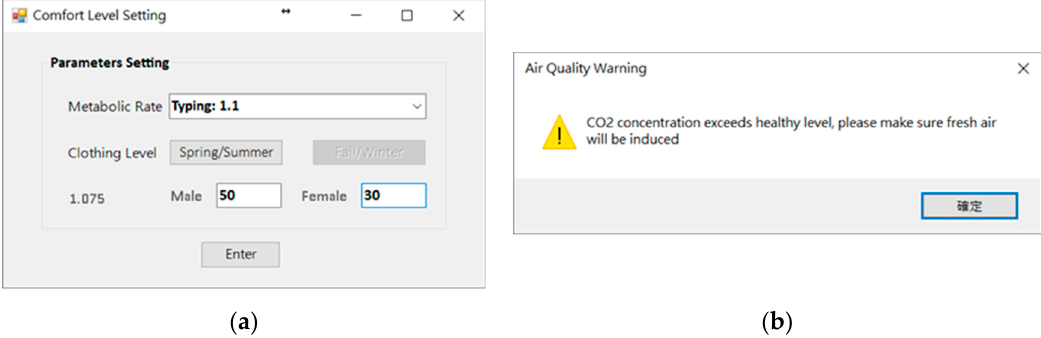
Figure 7. Setting and warning window of COZyBIM. ( a ) Activity Status and Clothing Setting Screen for Space Users; ( b ) Carbon Dioxide Concentration Detection Warning Window.